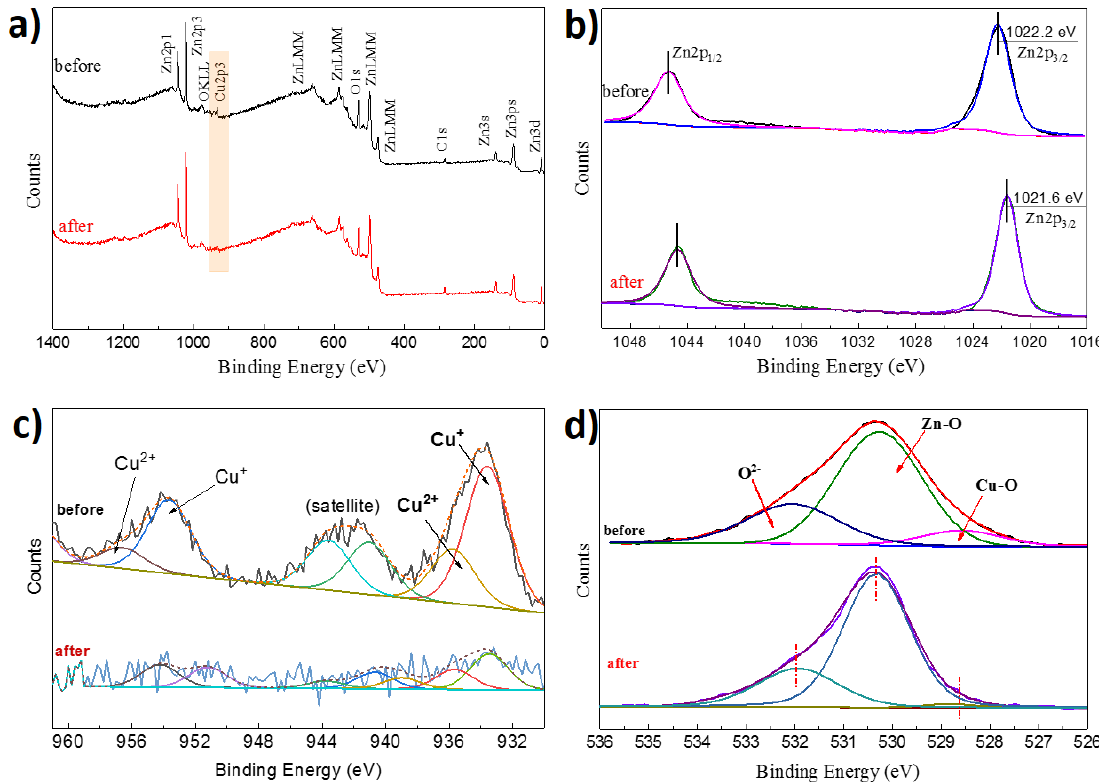
Figure 3. ( a ) X-ray photoelectron spectroscopy (XPS) survey spectra of ZnO/Cu x = 1.25 O; ( b ) Zn2p peak shifts during SMT degradation; ( c ) Cu2p shifts during SMT degradation; and ( d ) O1s shift observed during SMT degradation.